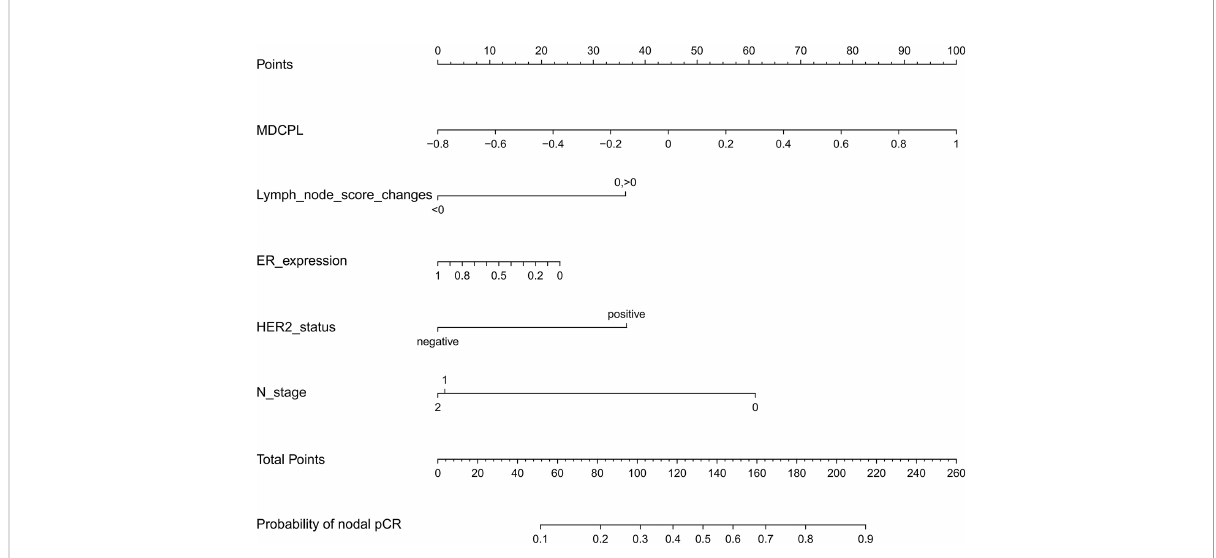
FIGURE 3 Nomogram for predicting the probability of apCR. Variables including MDCPL, LNS changes, percentage ER expression, HER2 status, and N stage were assigned points. Adding the total score of these variable points indicates the probability of apCR. The vertical line between the fi ve variables and the fi rst row can be summed as a total point, and by drawing a vertical line between the total point and the last row, the fi nal probability of apCR was obtained. apCR, axillary lymph node pathological complete response; ER, estrogen receptor; HER2, human epidermal growth factor receptor 2; LNS, lymph node score; MDCPL, maximum diameter change of primary